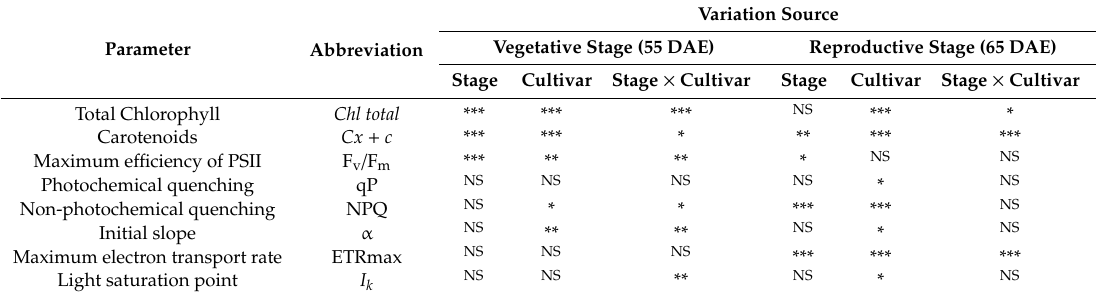
Table 1. Summary of the analysis of variance of the e ff ects of water stress on the physiological behavior of five bush bean